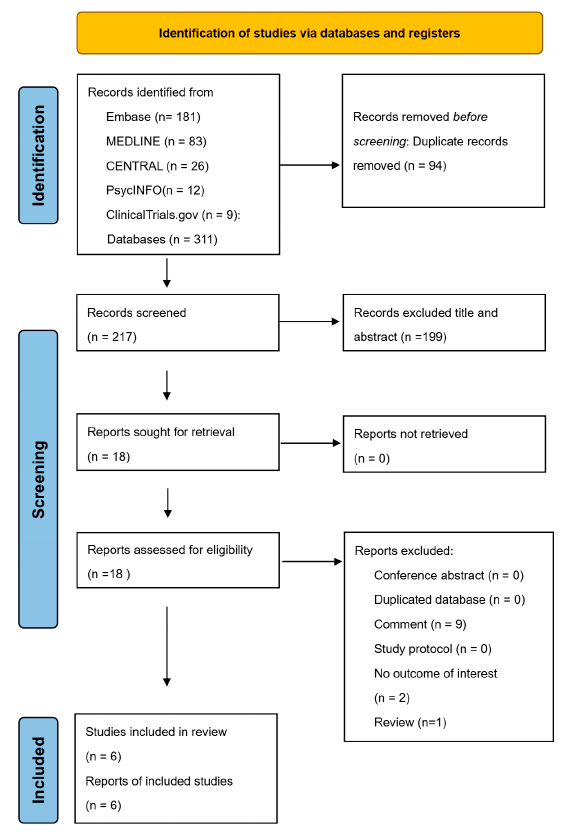
Figure 1. PRISMA 2020 flow diagram. Table 1. Demographic data of the included studies.